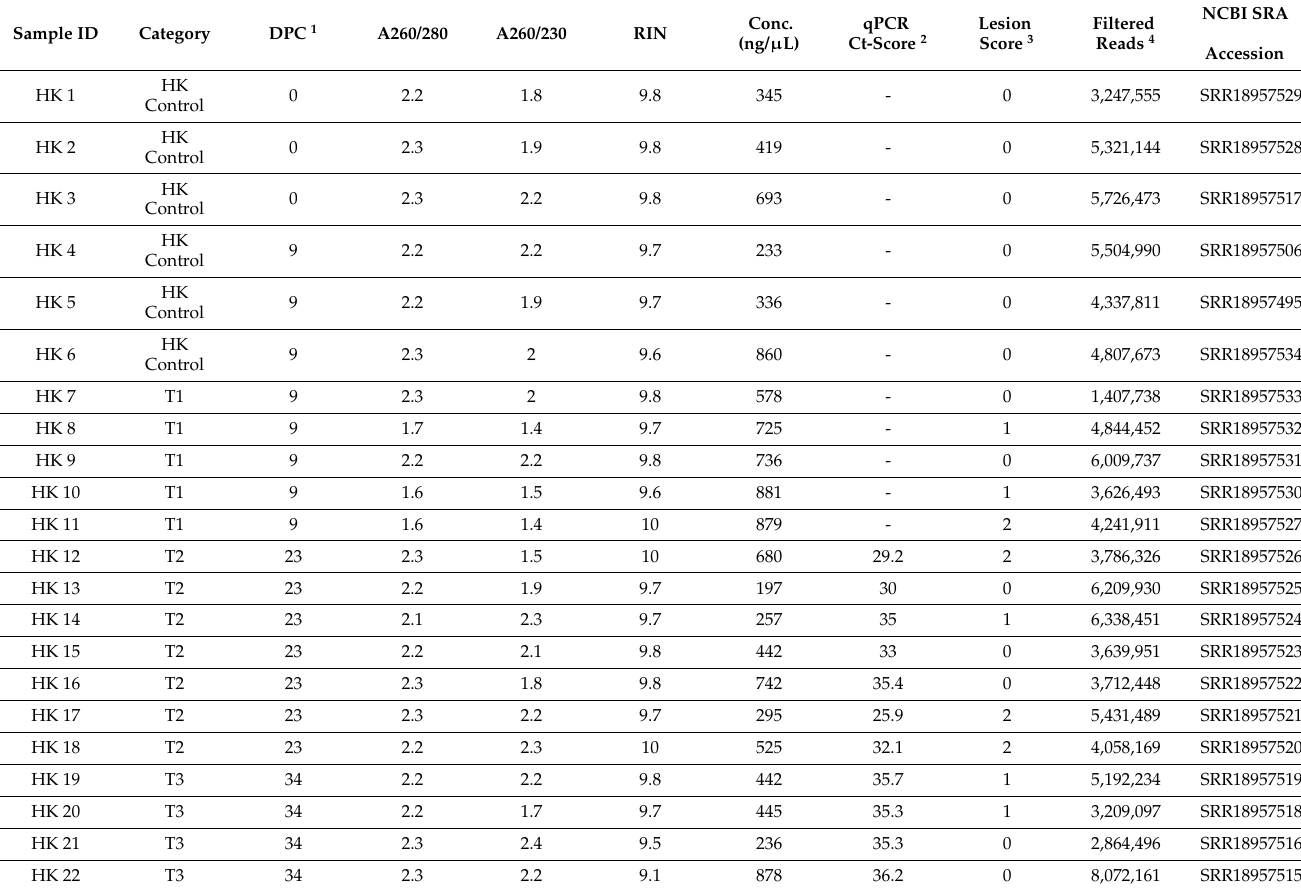
Table 1. Summary of HK samples, time points, RNA-extraction, Moritella measurement by qPCR, winter-ulcer-related lesion scores, and SRA accession